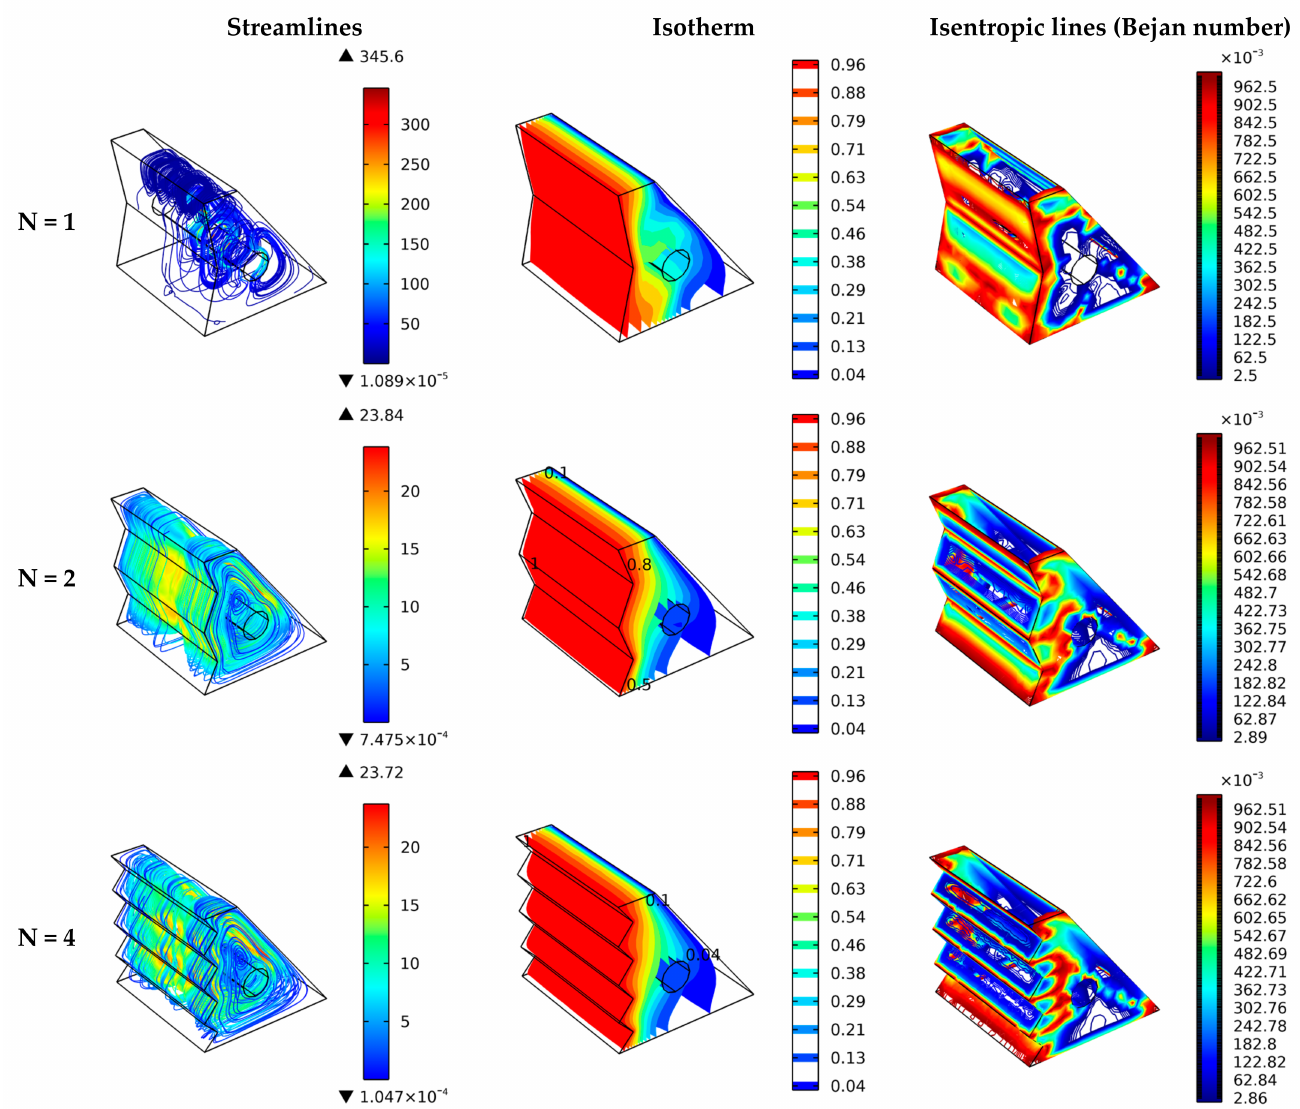
Figure 6. Three-dimensional surface plots to show the effect of the zigzag number on the streamlines, temperature in terms of dimensionless isotherms, and Bejan